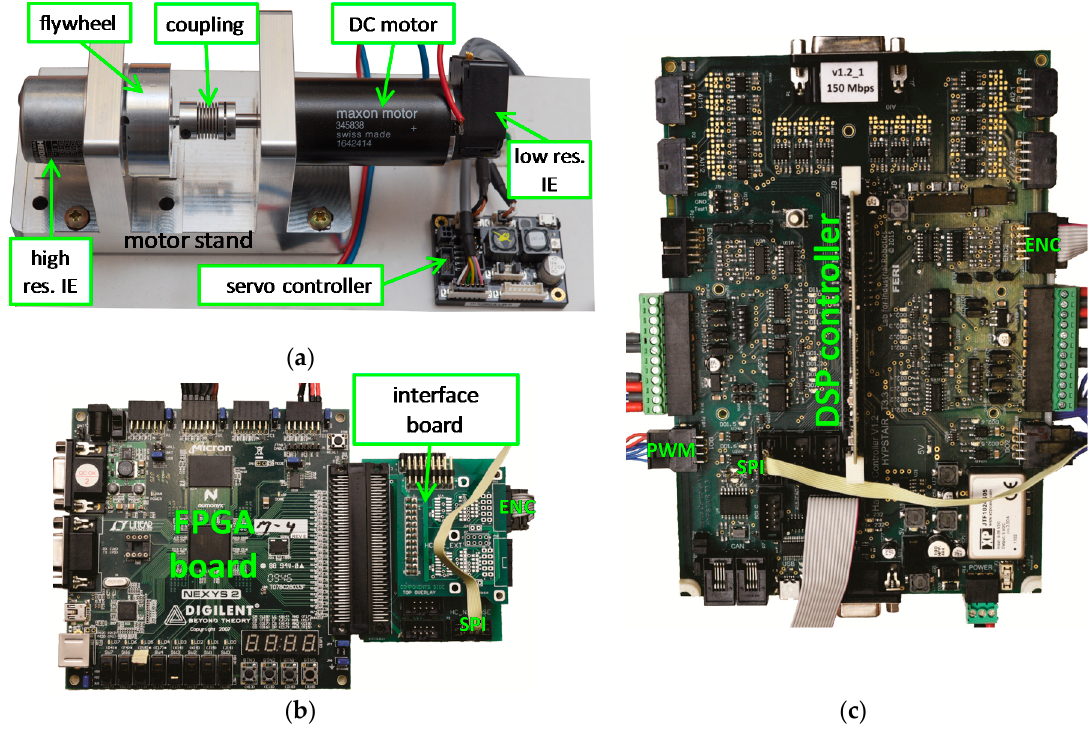
Figure 9. The main components of the experimental setup: ( a ) The mechanical servo drive system; the processing hardware electronics with ( b ) The FPGA board, and ( c ) The DSP controller.